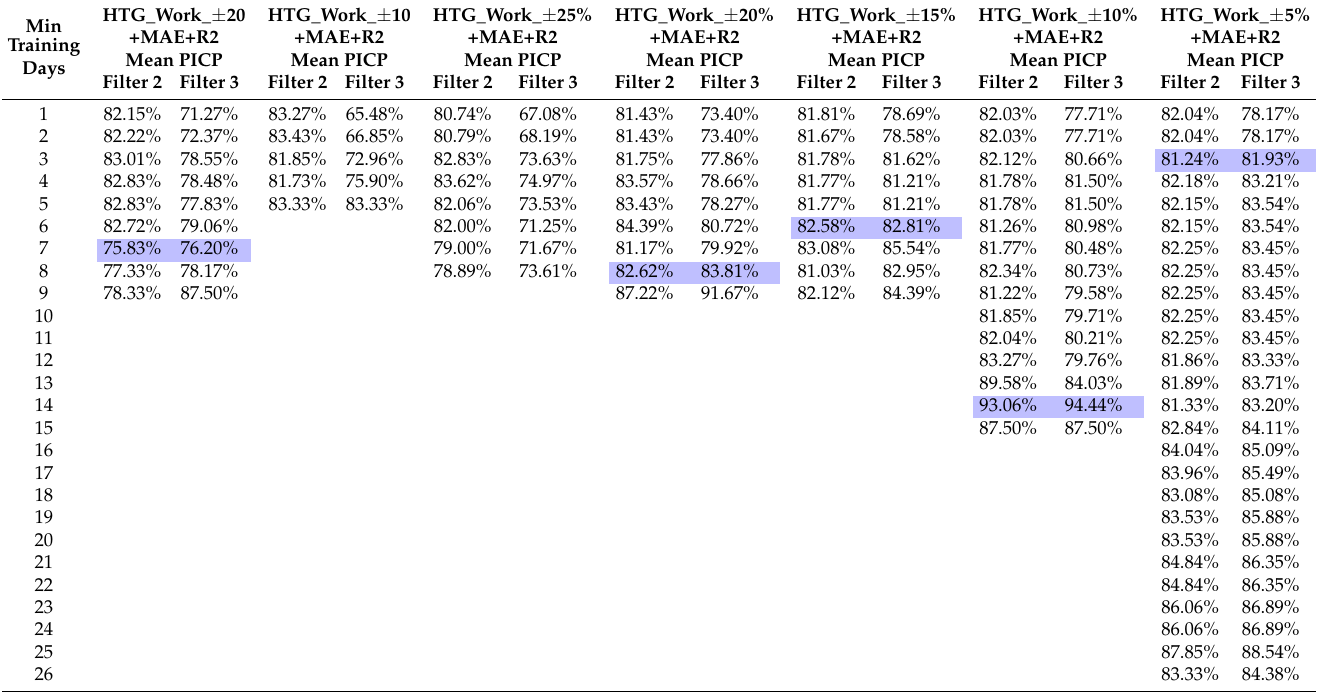
Table A3. Definition of the minimum number of training days required for each criterion within Filter 3. The highlighted cells show when the mean PICP of each criterion of Filter 3 improves the mean PICP of Filter